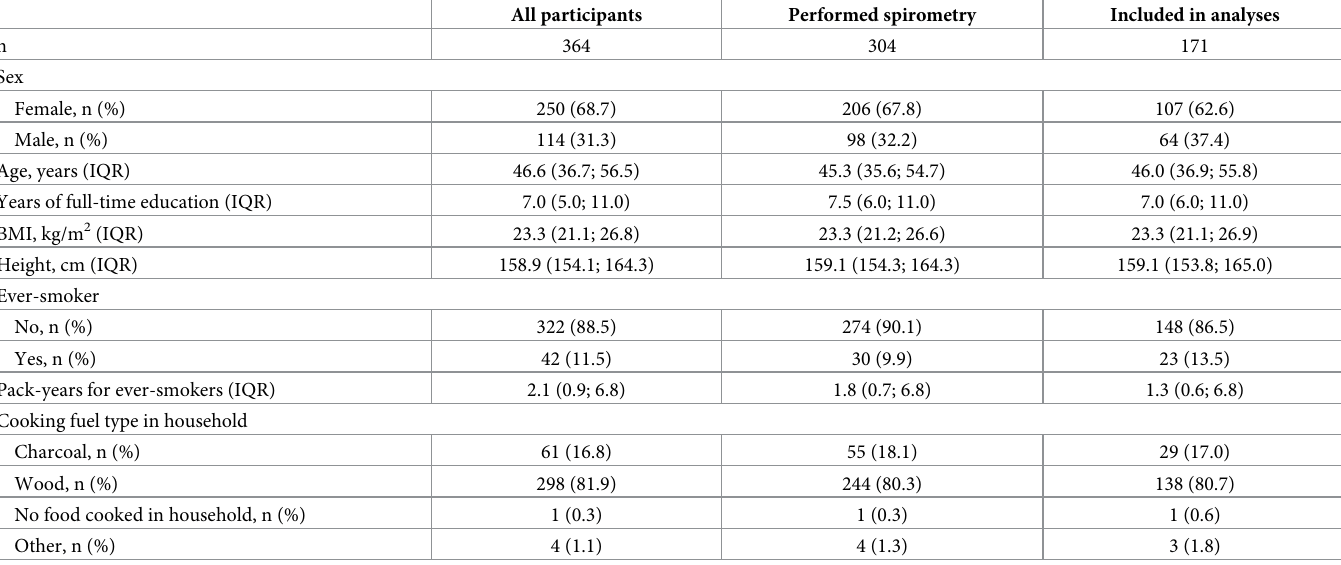
Table 1. Demographic characteristic of the